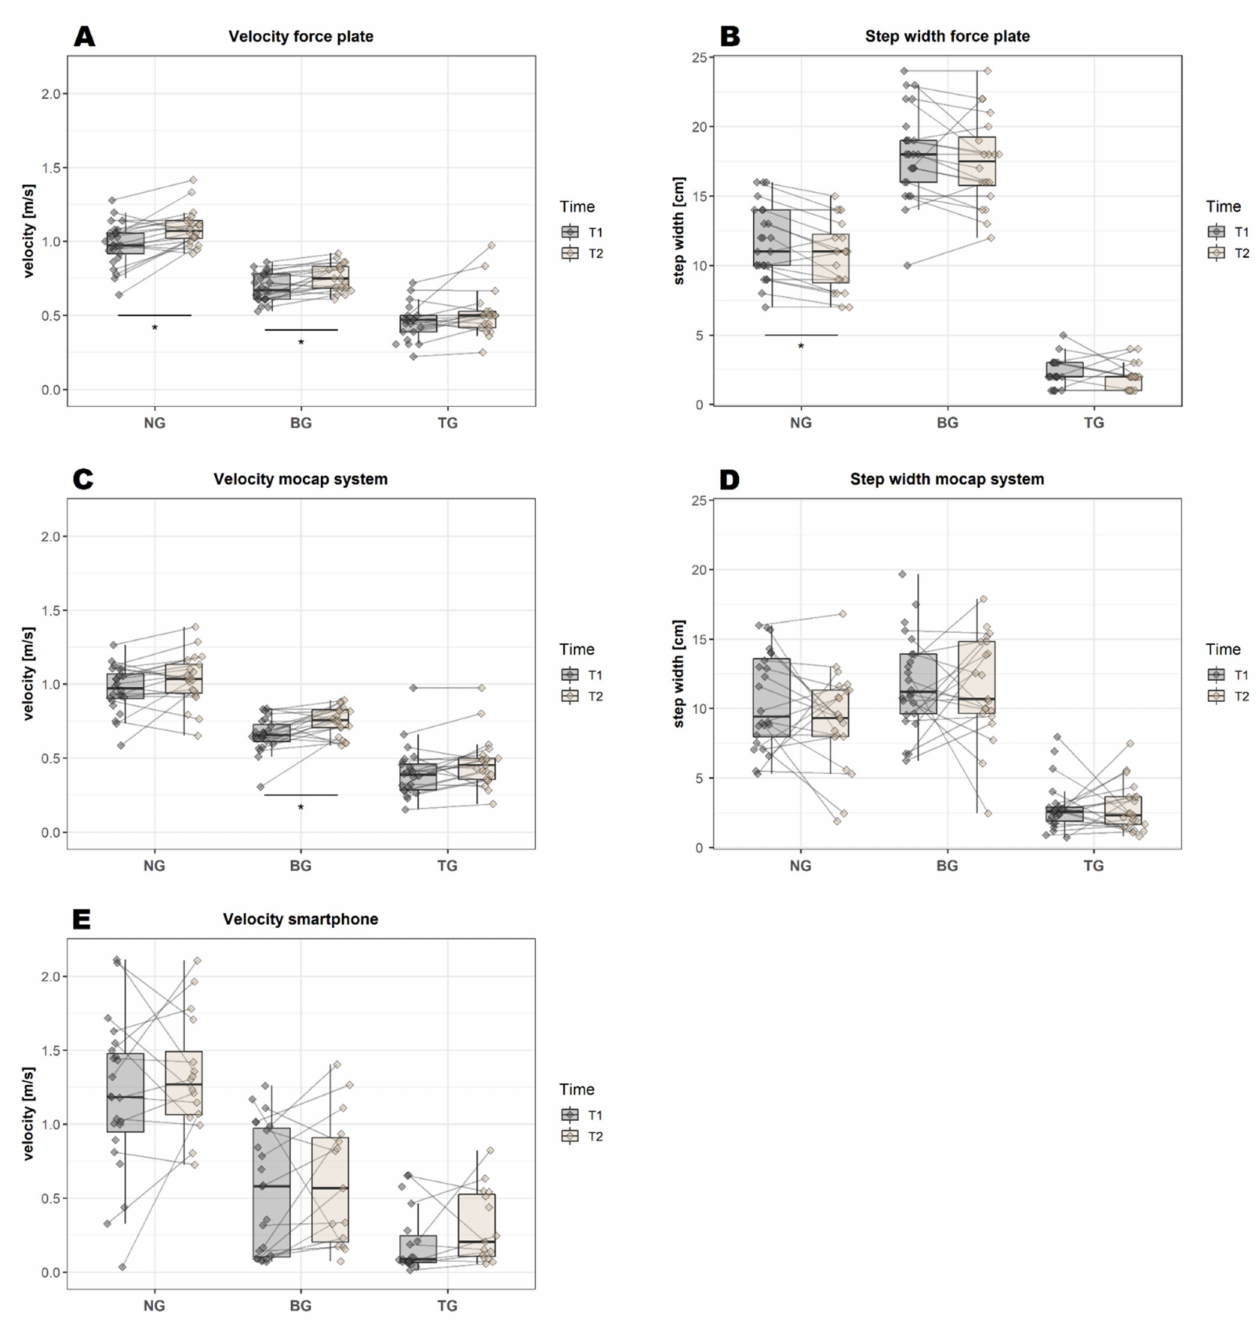
Figure 4. Graphical representation of the mean values of velocity and step width for all three gait analysis systems at T1 and T2 (before and after training). Significant differences over time (after Bonferroni correction) are highlighted by an asterisk. BG = backward gait, NG = normal gait, TG = tandem